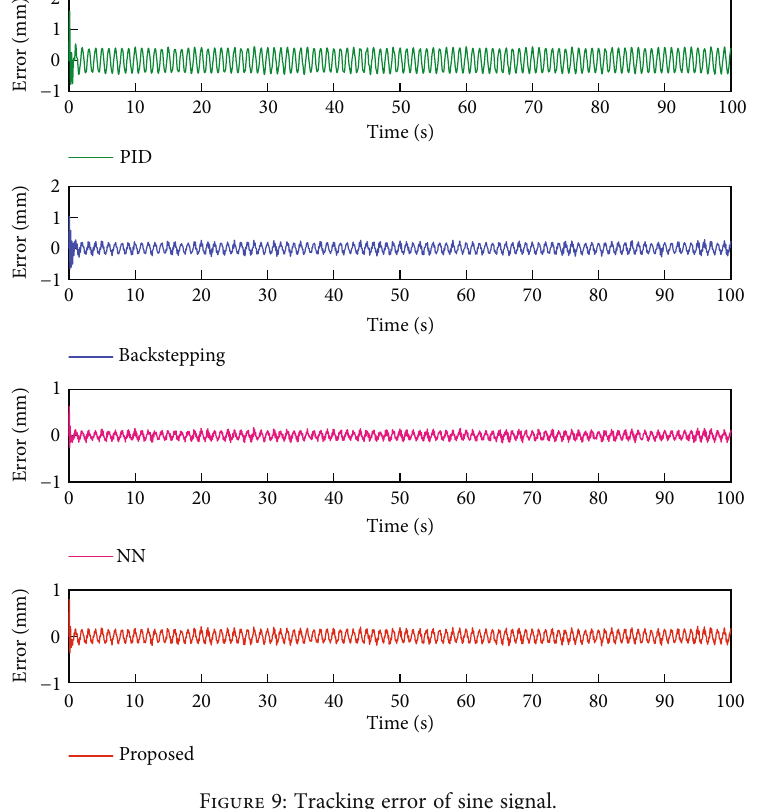
Figure 9: Tracking error of sine